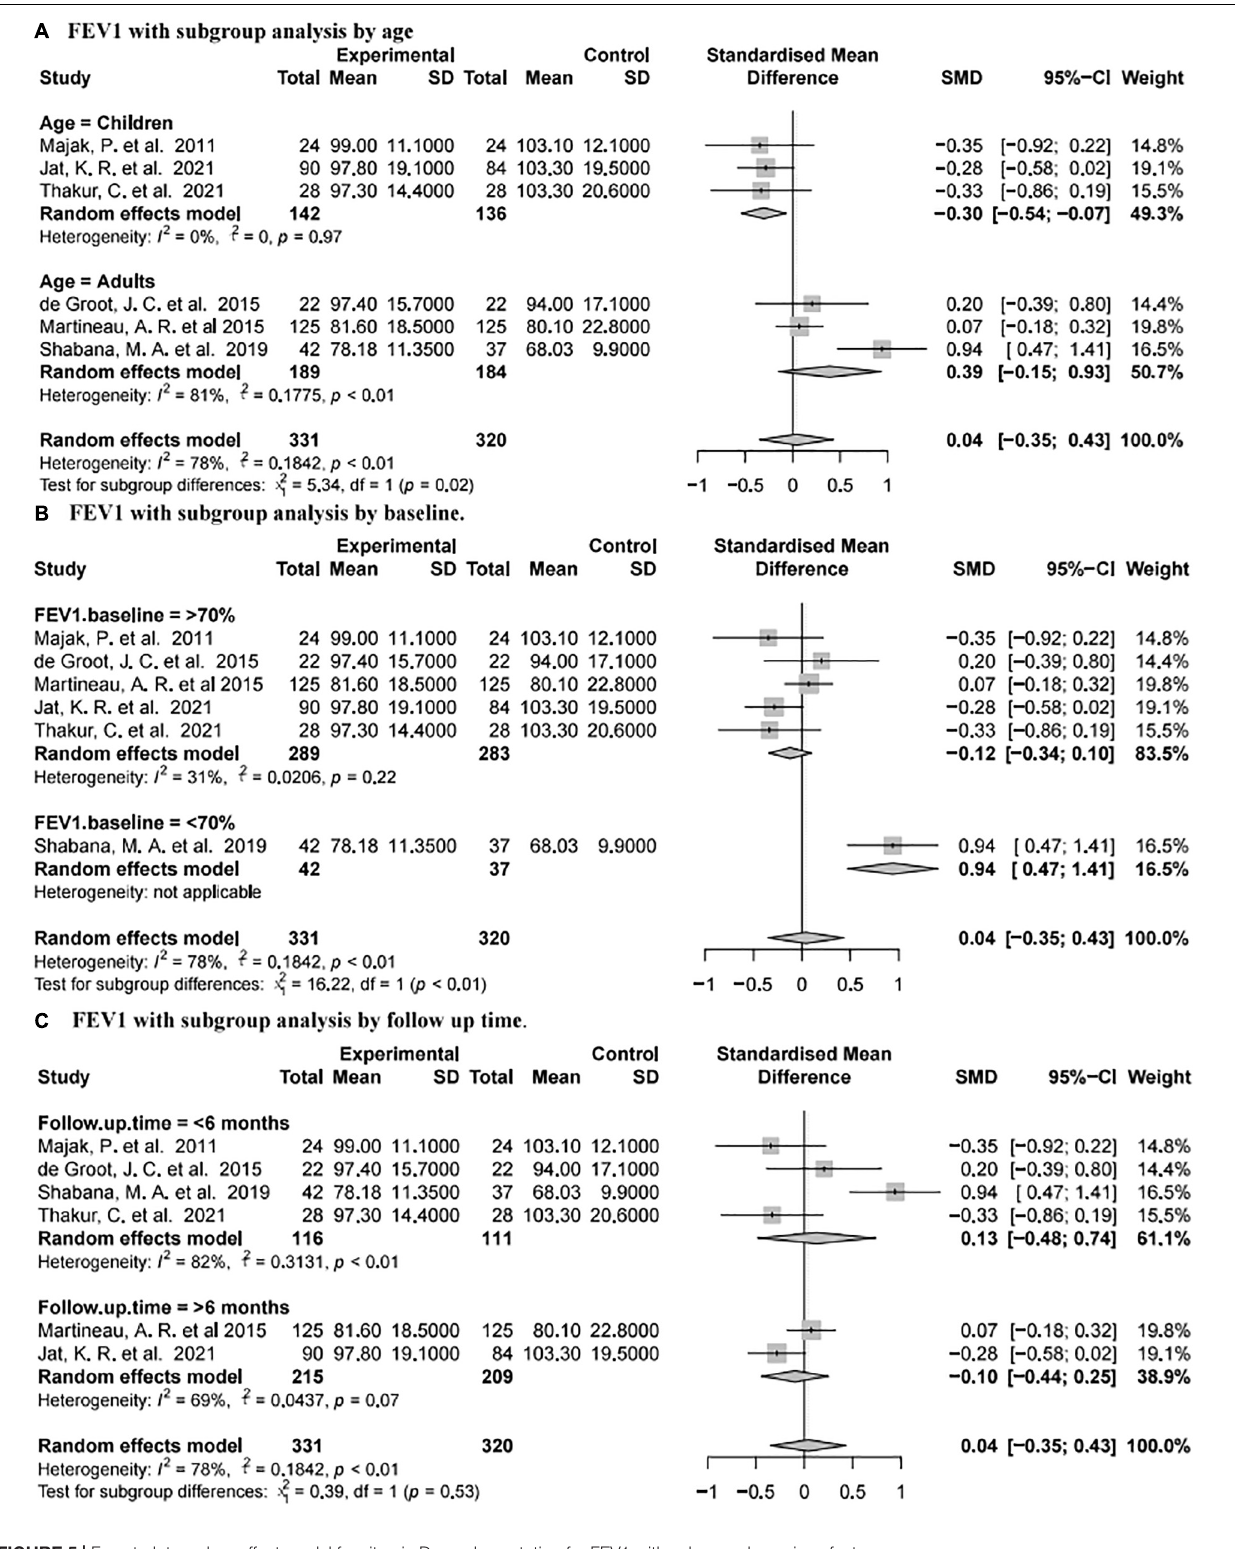
Frontiers in Nutrition |